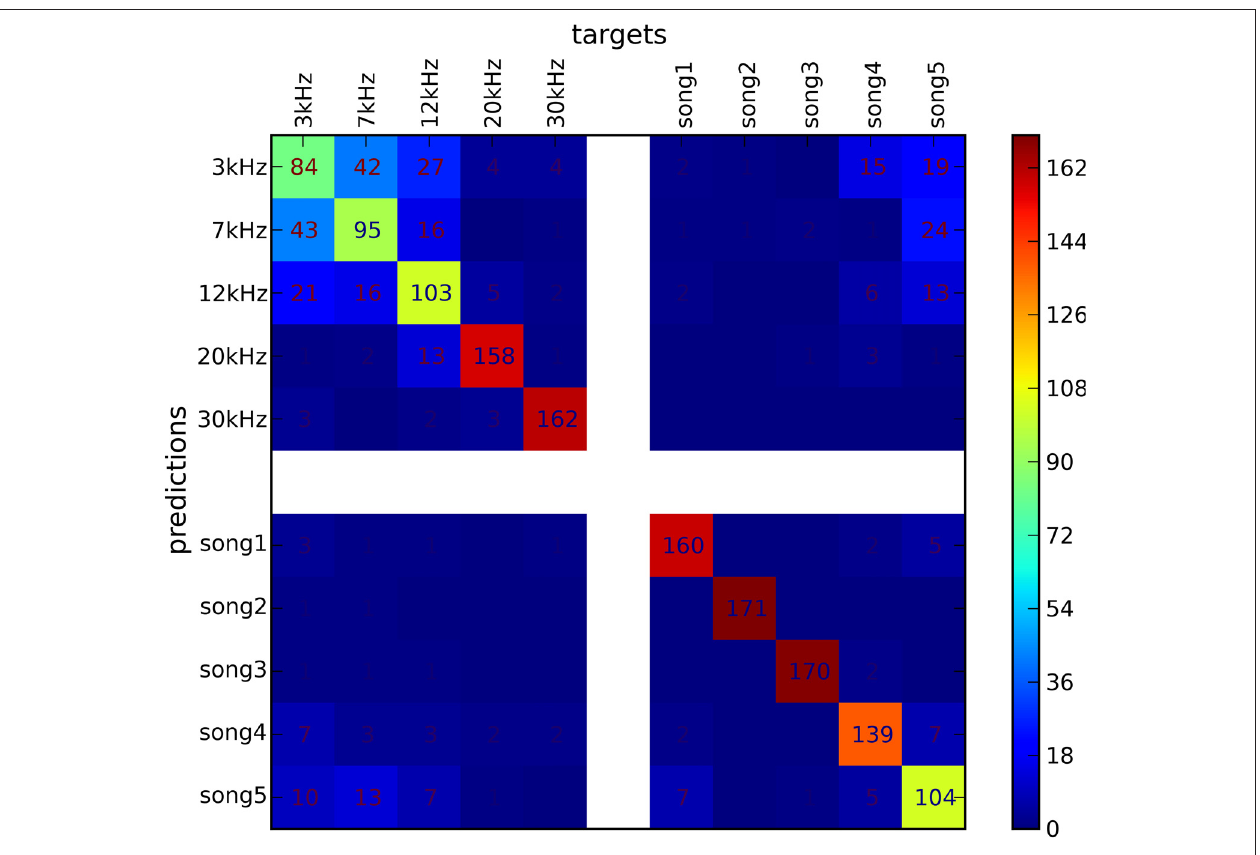
FIGURE 6 | Confusion matrix of SMLR classifi er predictions of stimulus conditions from of multiple unit recordings. The classifi er was trained to discriminate between stimuli of fi ve pure tones and fi ve natural sounds. Elements of the matrix (numeric values and color-mapped visualization) show the number of trials which were correctly (diagonal) or incorrectly